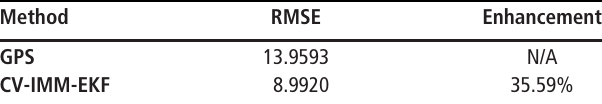
Table I CV-IMM-EKF and GPS error comparison